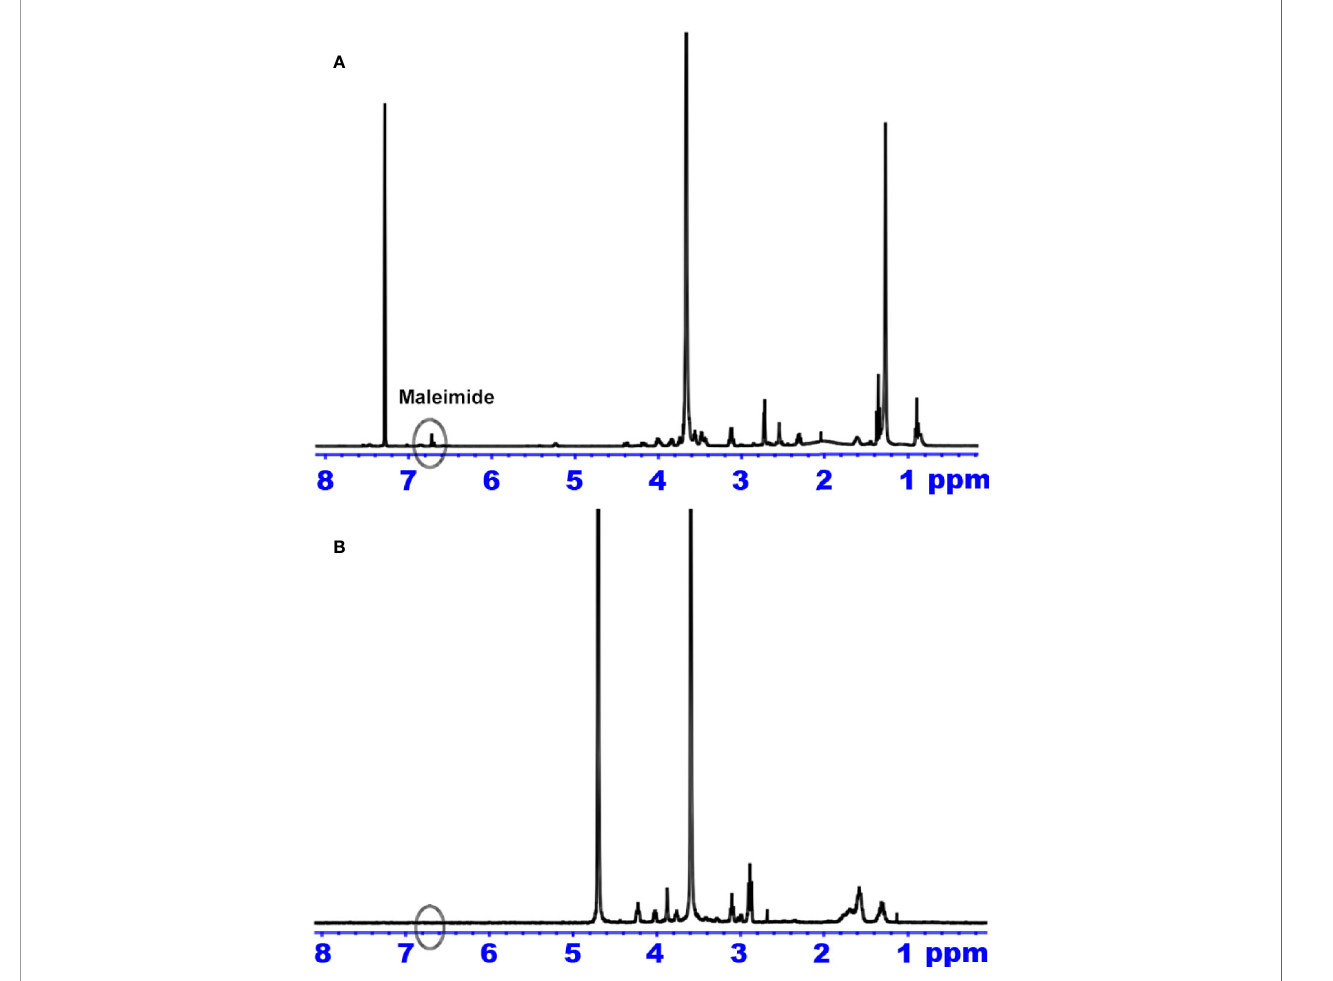
FIGURE 2 | 1 H NMR spectrum of Mal-PEG 2000 -DSPE (A) and CGKRK-PEG-DSPE (B)